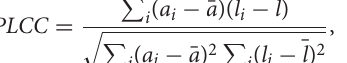
performance of the corresponding IQA metric is better.